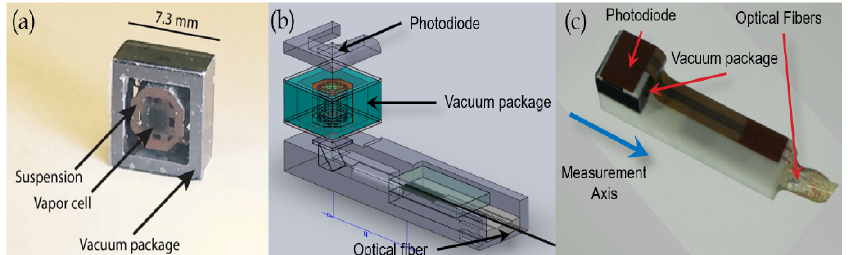
Figure 18. A fiber-optically coupled chip-scale atomic magnetometer. ( a ) the vacuum assembly housing the vapor cell; ( b ) a schematic of the optical bench; ( c ) a photograph of the final package [8].